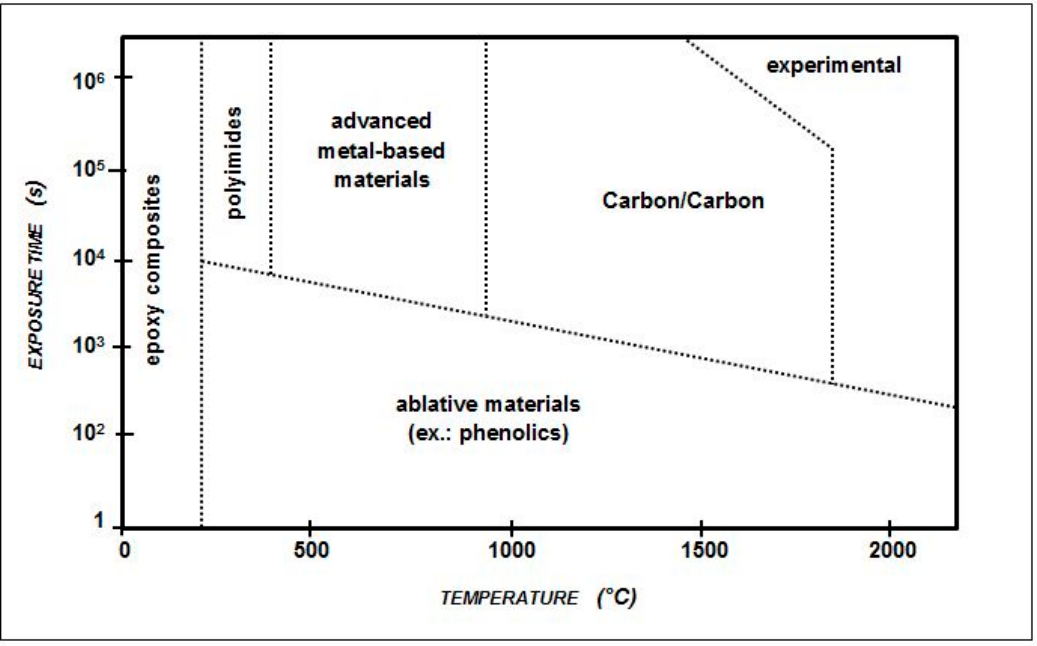
Figure 1. Effects of time and temperature on the ability of various composites to retain their properties [39].